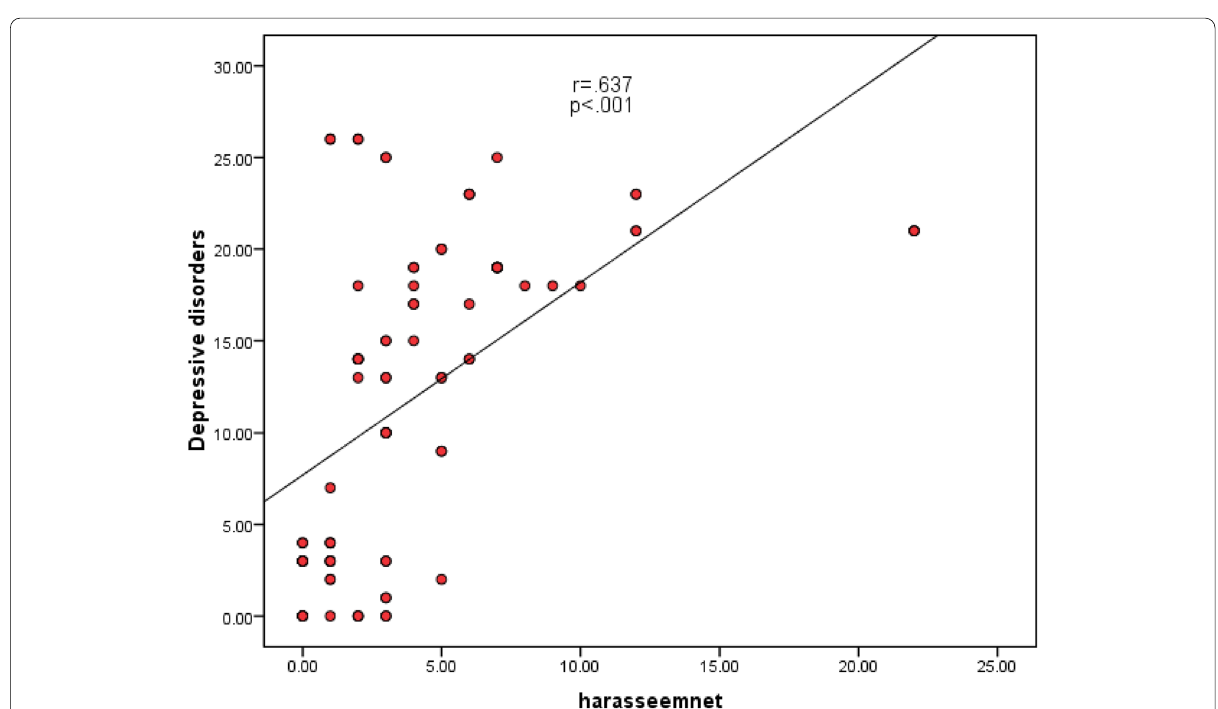
Fig. 5 Scatter diagram showing a correlation between harassment and depressive disorder